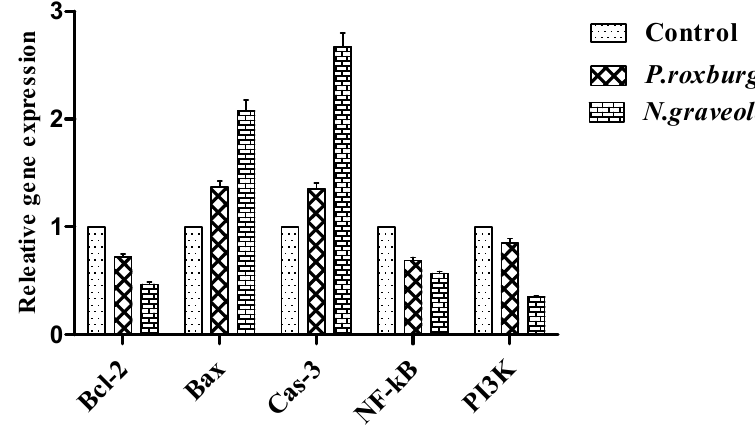
Figure 11. Effect of P. roxburghii and N. graveolens extracts on Bcl-2, Bax, Cas3, NF-kB, and PI3k genes